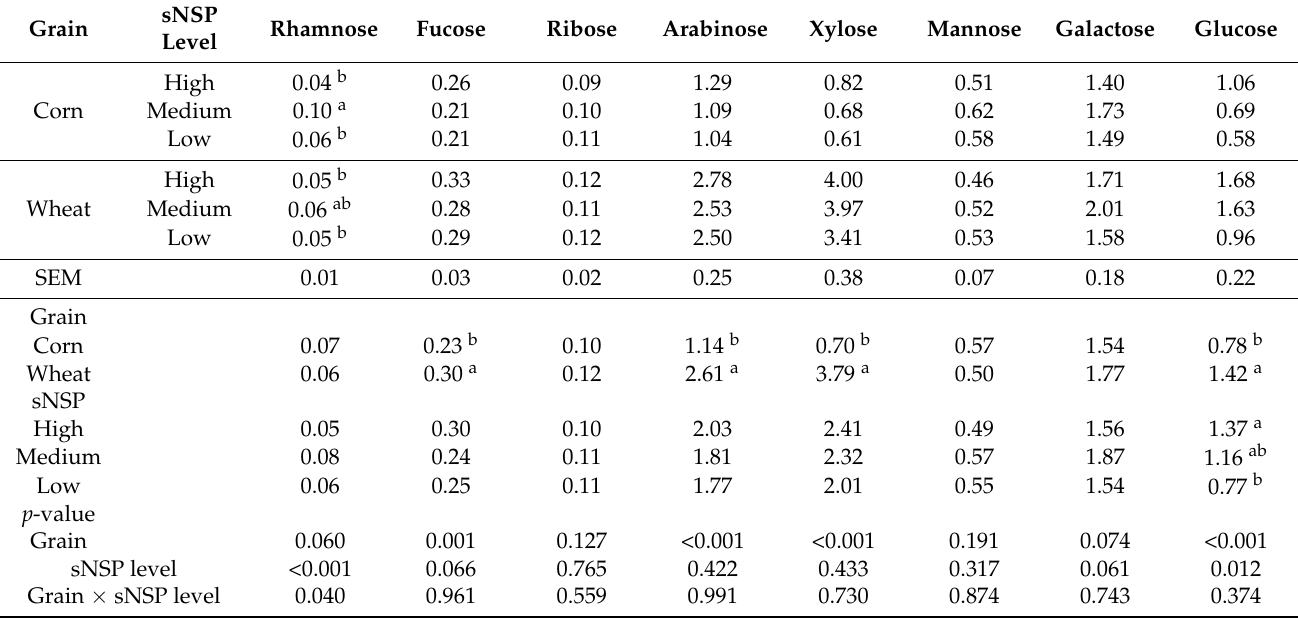
Table 11. Effect of dietary soluble NSP (sNSP) level and grain source on apparent total tract flow (g/kg DM intake) of soluble non-starch polysaccharide sugar residues at d